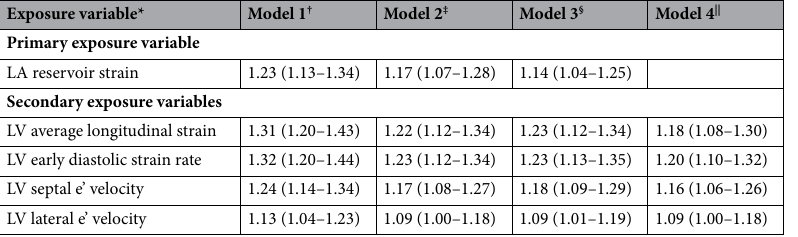
Table 2. Associations between myocardial mechanics and incident ischemic stroke in the cardiovascular health study. LA, left atrial; LV, left ventricular. *Reported results represent the hazard ratio (95% confidence interval) for ischemic stroke per each standard deviation absolute decrease in strain and decrease in strain rate and e’ velocity. Lower absolute values represent worse strain. † Adjusted for age, race, sex, study site, speckle- tracking analyst, and chamber-specific echocardiogram image quality. ‡ Adjusted for variables in Model 1 plus education, body mass index, coronary heart disease, heart failure, diabetes, systolic blood pressure, anti-hypertension medication, high-density lipoprotein level, low-density lipoprotein level, log-transformed triglyceride level, smoking status, and LV ejection fraction. § Adjusted for variables in Model 2 plus atrial fibrillation as a time-varying covariate. || Adjusted for variables in Model 2 plus LA reservoir strain and LA image quality score. The purpose of this model was to help assess whether the relationships between LV mechanics and stroke were mediated by LA mechanics.